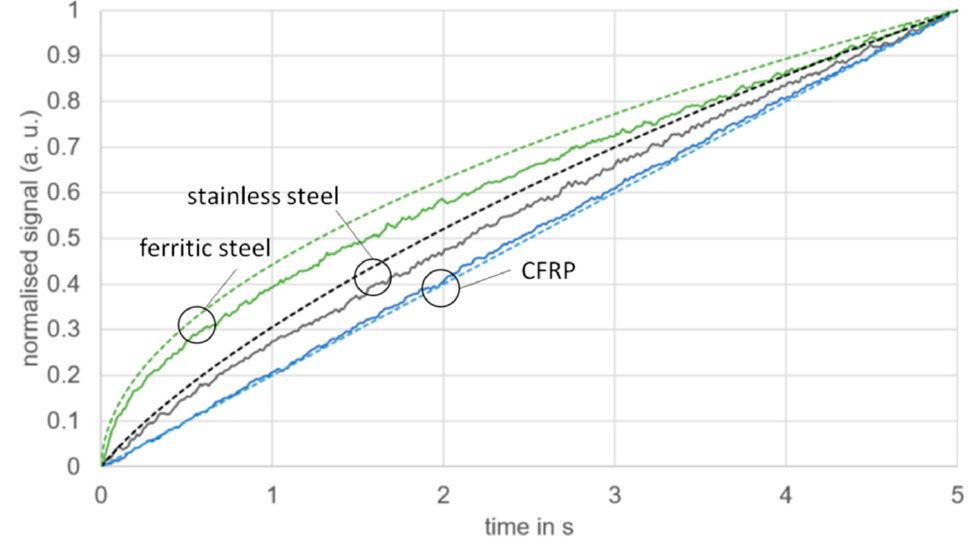
Figure 4. Normalised thermal signal after begin of induction heating obtained for ferritic steel, stainless steel and CFRP at an induction frequency of 10 kHz. Solid lines: experiment, dashed lines: theory.